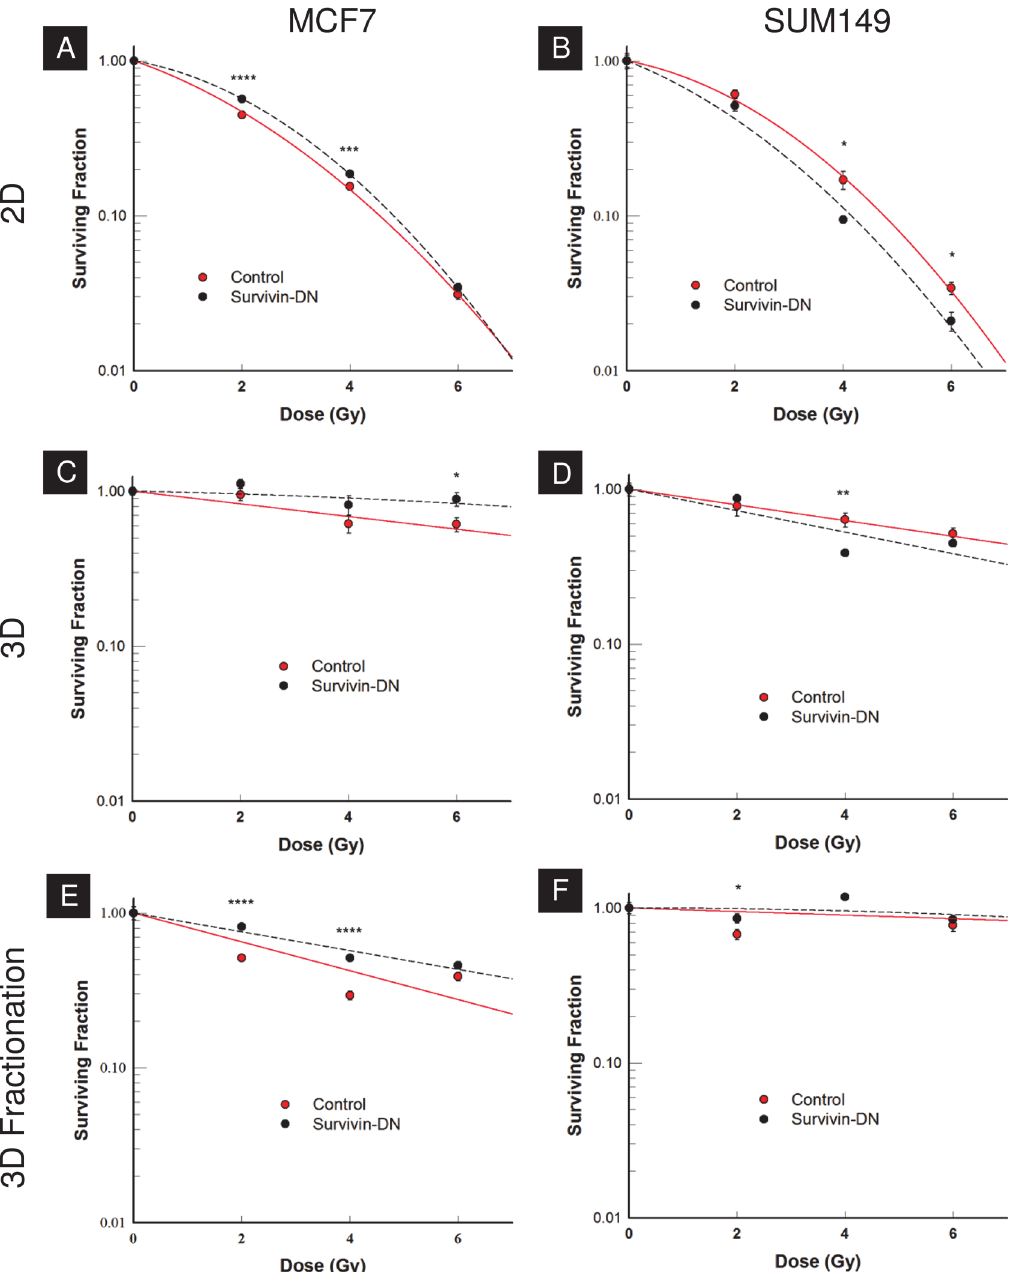
Fig 5. Representative figures for monolayer and mammosphere clonogenic assays in MCF7 and SUM149. A,C,E) MCF7 survivin-DN cells are radio- protective in monolayer cultures, mammosphere cultures, and also mammosphere cultures undergoing a fractionated regimen. B) SUM149 survivin-DN cells are radiosensitive compared to the control in monolayer cultures. D,F) SUM149 survivin-DN cells show no statistical difference in response to radiation, for both mammosphere cultures and mammosphere cultures exposed to a fractionated regiment. Error bars indicate standard